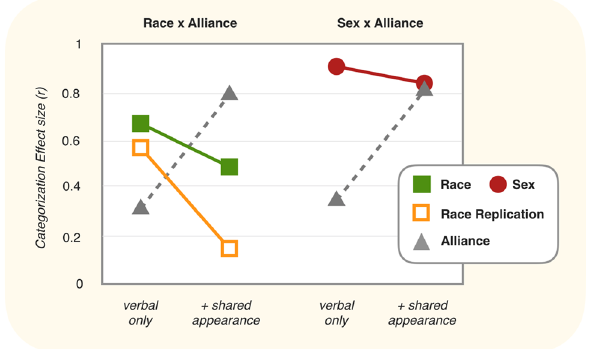
Figure 1. Data reported in Kurzban et al. (2001). Categorization effect size describes the degree to which participants within each condition made more within-category memory errors than between-category memory errors. The effect size is calculated as the difference in means weighted by the variance within those means, and is standardized to range between 0 and